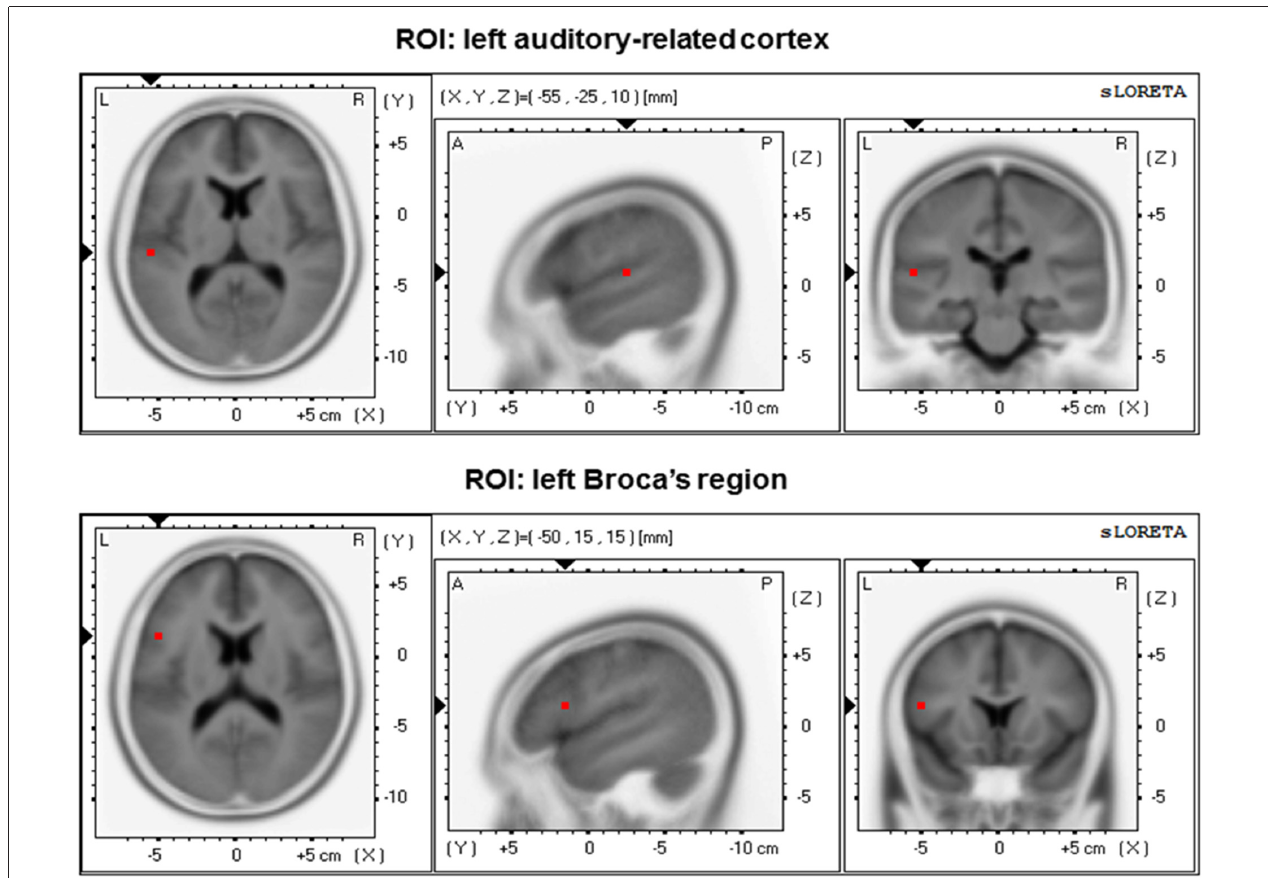
FIGURE 1 | Regions of interest (ROIs) position within the 3D MNI space. Left: transversal view; middle: sagittal view; right: coronal view.